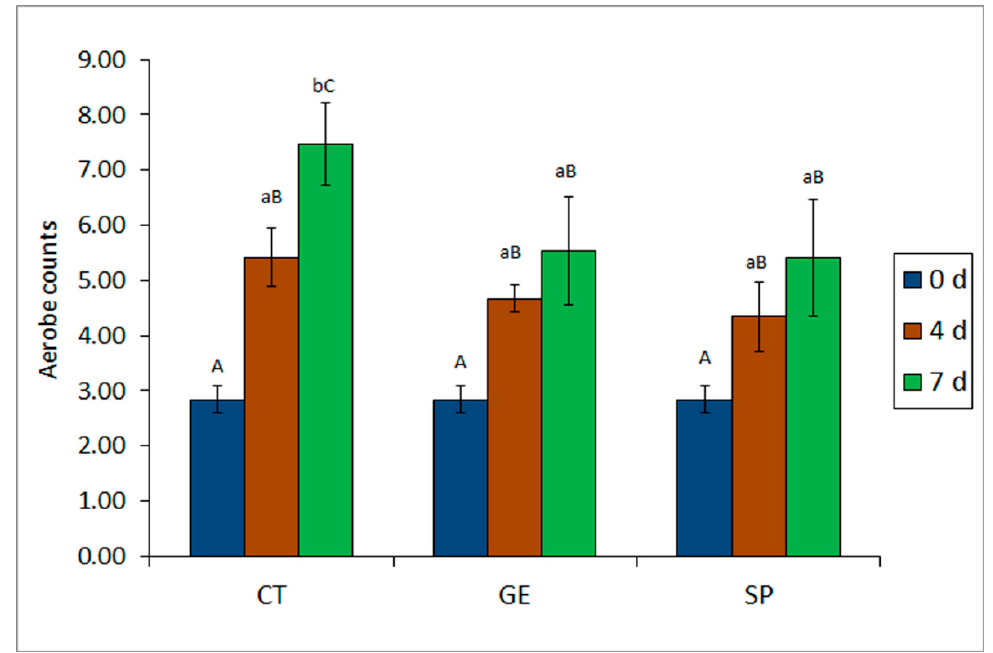
Figure 1. Aerobes count assessment (log CFU g − 1 muscle) * in mackerel muscle stored under di ff erent packaging conditions **. * Average values of three replicates ( n = 3); standard deviations are indicated by bars. Average values accompanied by di ff erent lower case letters (a, b) indicate significant di ff erences ( p < 0.05) as a result of packaging condition; average values accompanied by capital letters (A, B, C) indicate significant di ff erences ( p < 0.05) as a result of refrigeration time. ** Packaging conditions: CT (control polyethylene), GE (control gelatine) and SP